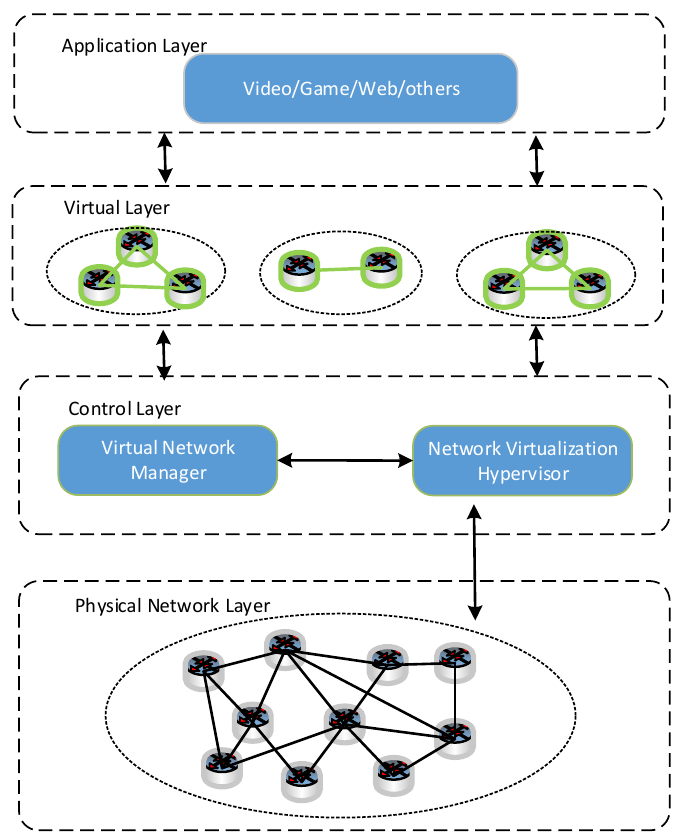
Figure 1. Virtualization-enabled SDN architecture.